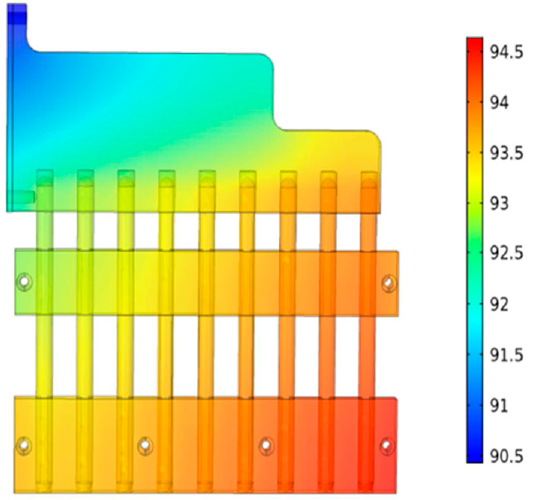
Figure 11. Temperature profile (Type IV).